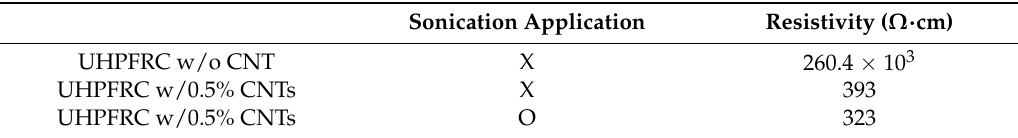
Table 5. Sonication effect on electrical resistivity of UHPFRC with CNTs.